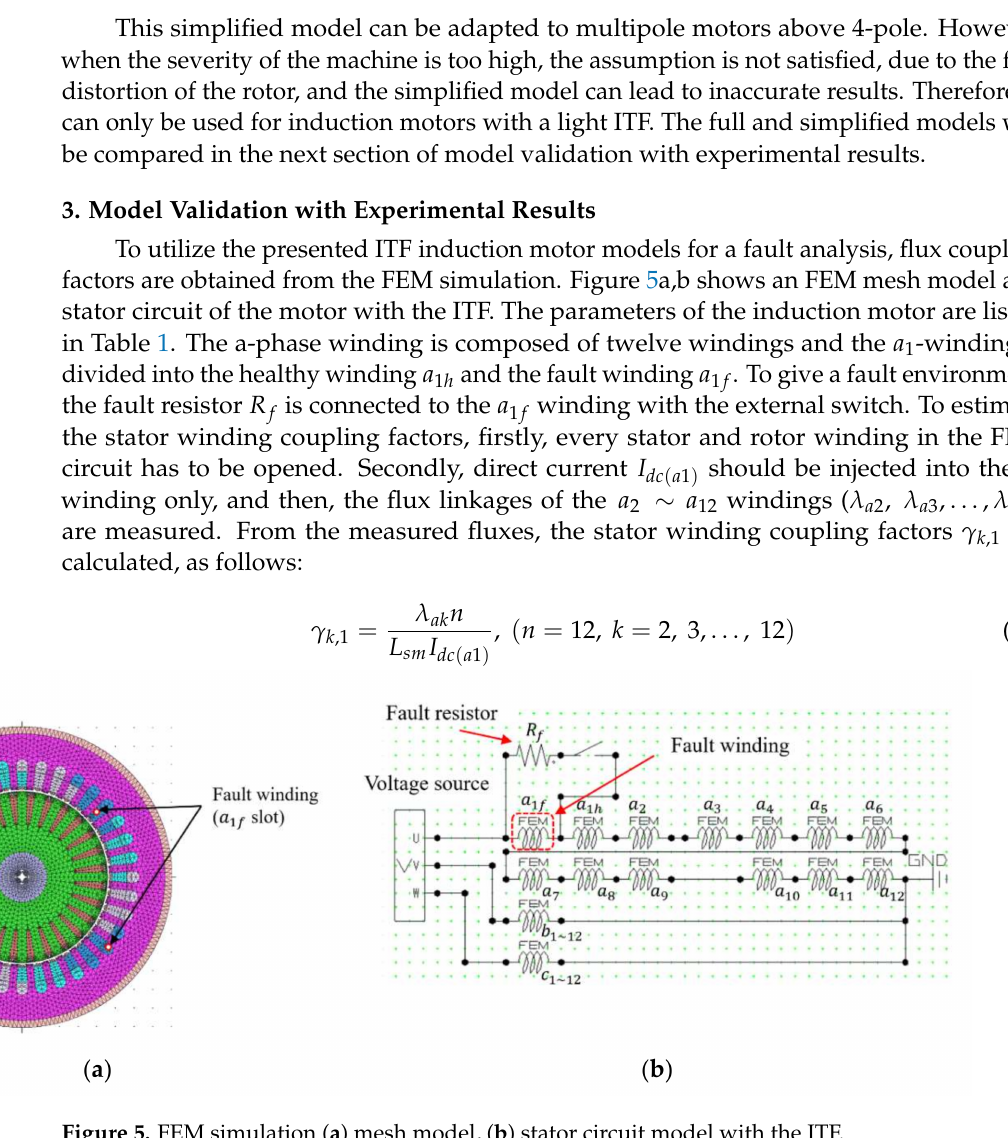
Figure 5. FEM simulation ( a ) mesh model, ( b ) stator circuit model with the